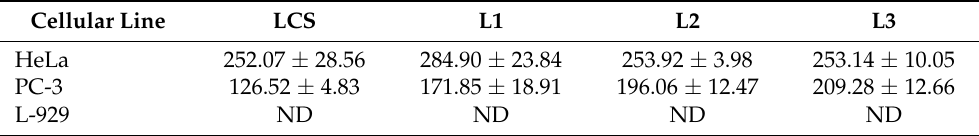
Table 5. IC 50 of the lignin samples in the different cell